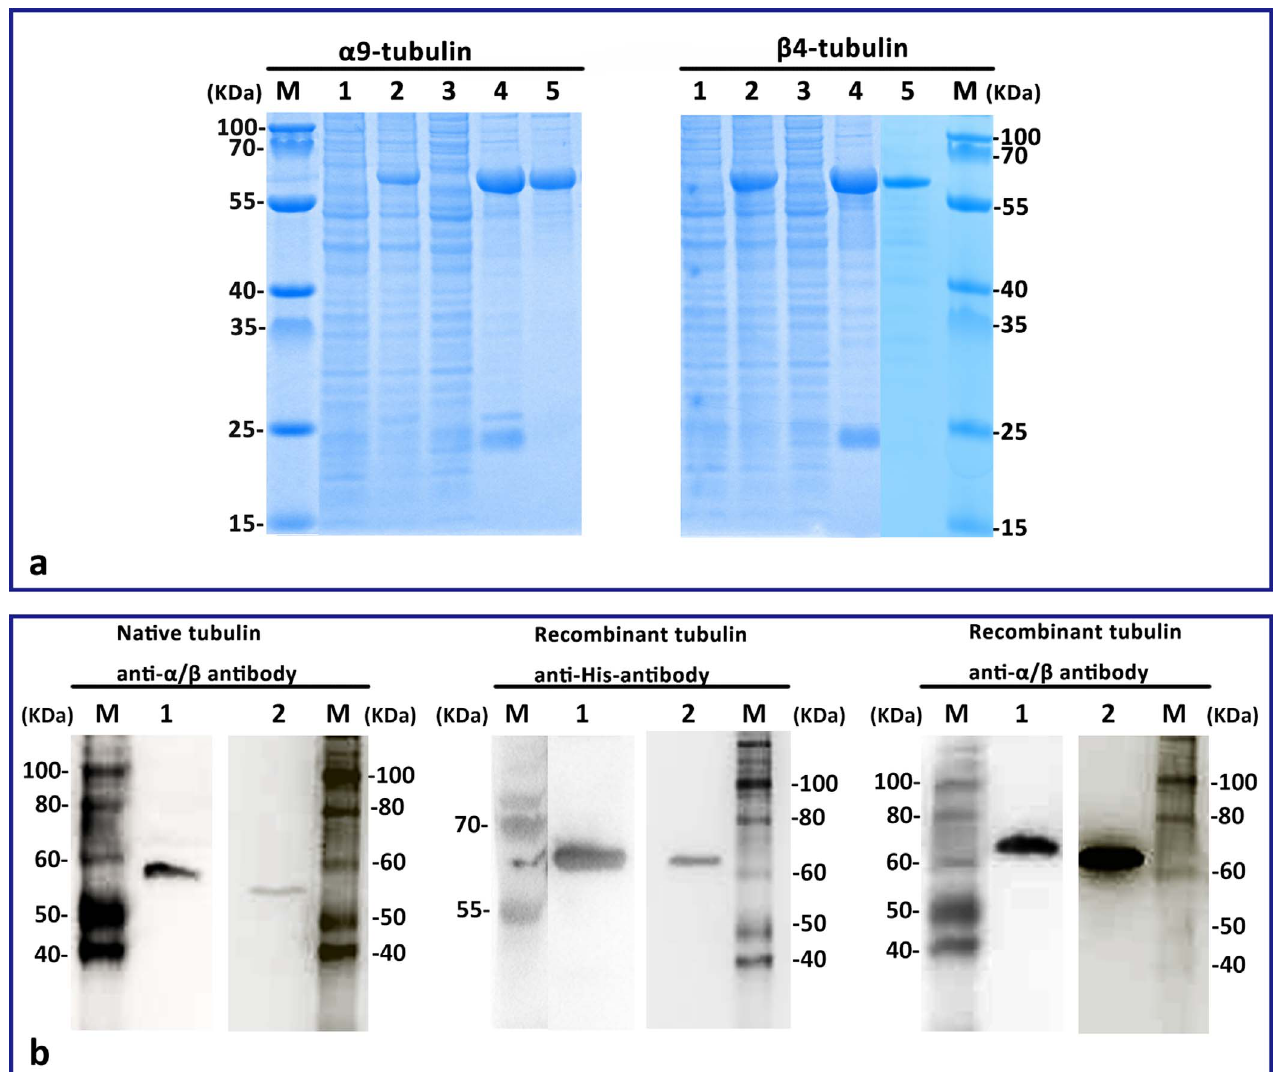
Figure 1. The cloning and expression of a 9 - and b 4 -tubulin. (a) The expression of a 9 - and b 4 -tubulin in E. coli BL21 (DE3). M: standard protein molecular weight marker, lane 1: negative control without induction, lane 2: induced control, lane 3: the supernatant after sonication, lane 4: the pellet after sonication, and lane 5: purified recombinant tubulin. (b) Western blot analysis. M: standard protein molecular weight marker, lane 1: a -tubulin, lane 2: b